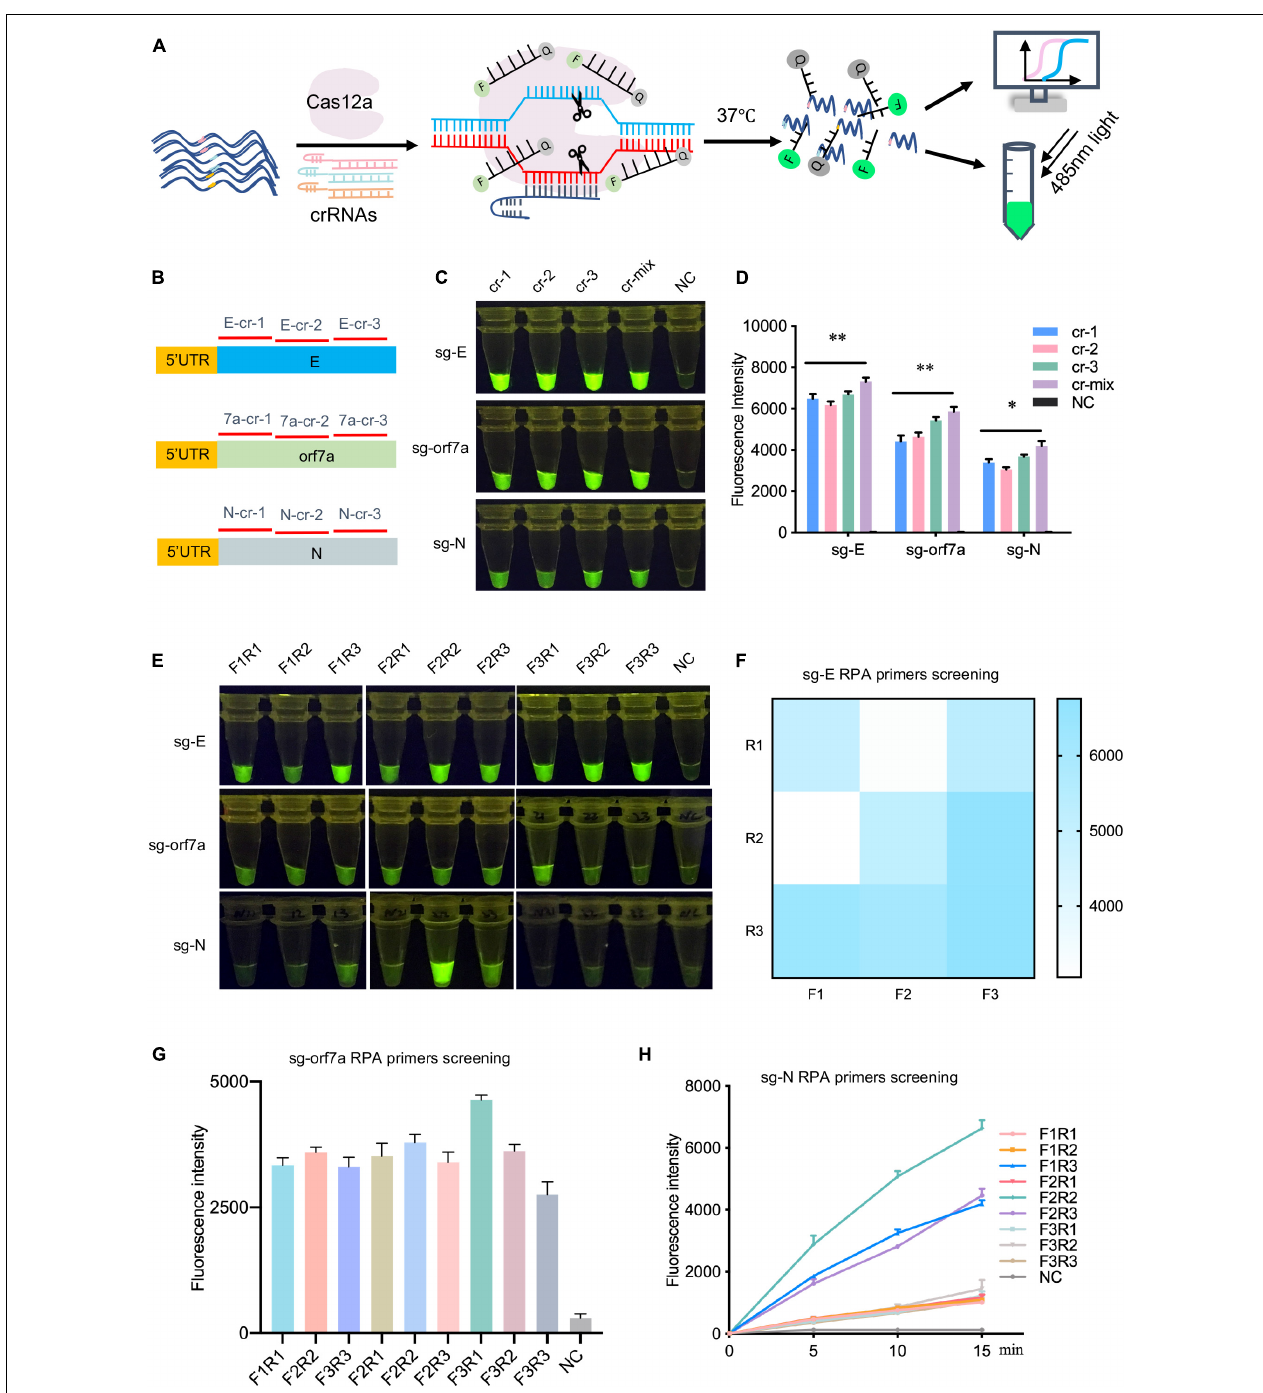
FIGURE 2 | Screening of crRNAs and RT-RPA primers targeting sgRNA of SARS-CoV-2 E , orf7a or N . (A) Schematic illustration of crRNAs design and screening. For each target, three crRNAs were designed and synthesized, the efficiency of crRNAs was evaluated using CRISPR/Cas12a mediated fluorescence reporter assay. (B) The location of crRNAs designed to target sgRNAs of SARS-CoV-2 E, orf7a or N. 5 (cid:48) UTR, the common leader sequence at 5 (cid:48) flank of sgRNAs of SARS-CoV-2. cr-1, crRNA-1, cr-2, crRNA-2, cr-3, crRNA-3, cr-mix, mixture of crRNA-1,2,3 with equal amount. (C) crRNAs screening assay targeting sgRNA of E , orf7a , or N . The fluorescent images at 15 min of the reaction were shown. cr-1, crRNA-1, cr-2, crRNA-2, cr-3, crRNA-3, cr-mix, mixture of crRNA-1,2,3 with equal amount, NC, Negative Control. (D) Fluorescent intensities analysis of the fluorescent signal in panel (C) . Quantification was performed using ImageJ and analyzed using GraphPad Prism 7.0. (E) RT-RPA primers screening assay. The fluorescent images at 15 min of the reaction were shown. (F–H) The fluorescent intensity of sg-E (F) , sg-orf7a (G) , sg-N (H) RT-RPA primers screening assay. Quantification was performed using ImageJ and analyzed using GraphPad Prism 7.0. Data were collected from at least three independent experiments and was presented as Mean ± SD, and significance was considered as * p < 0.05; ** p < 0.01.